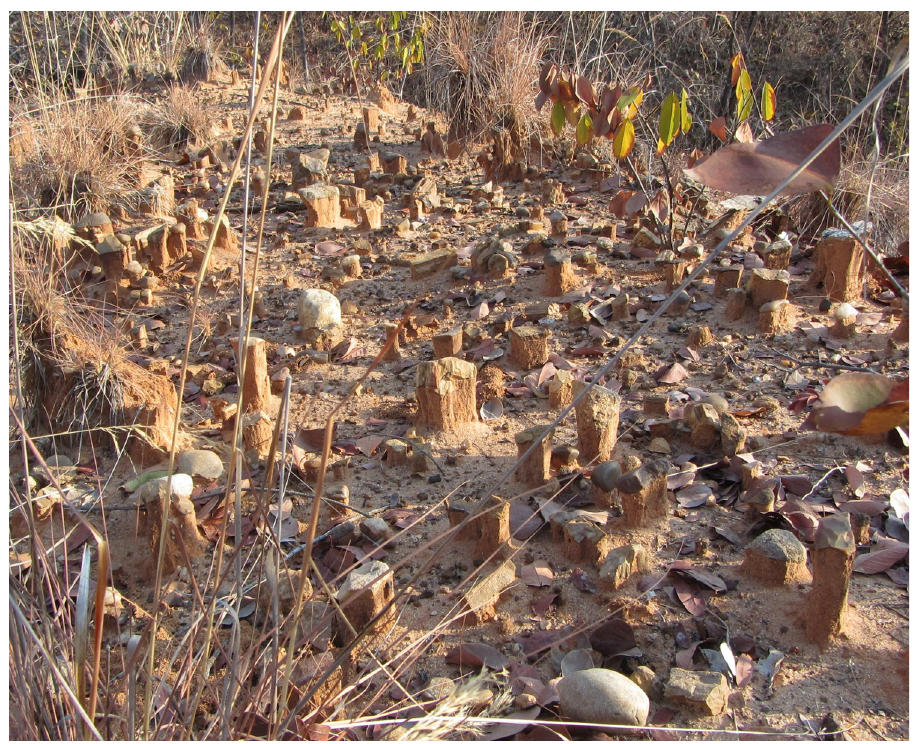
Fig 9. Sheet-wash action. Pedicles under large clasts and artefacts formed as the fine fraction is removed by sheet- wash (here in the vicinity of SW60).